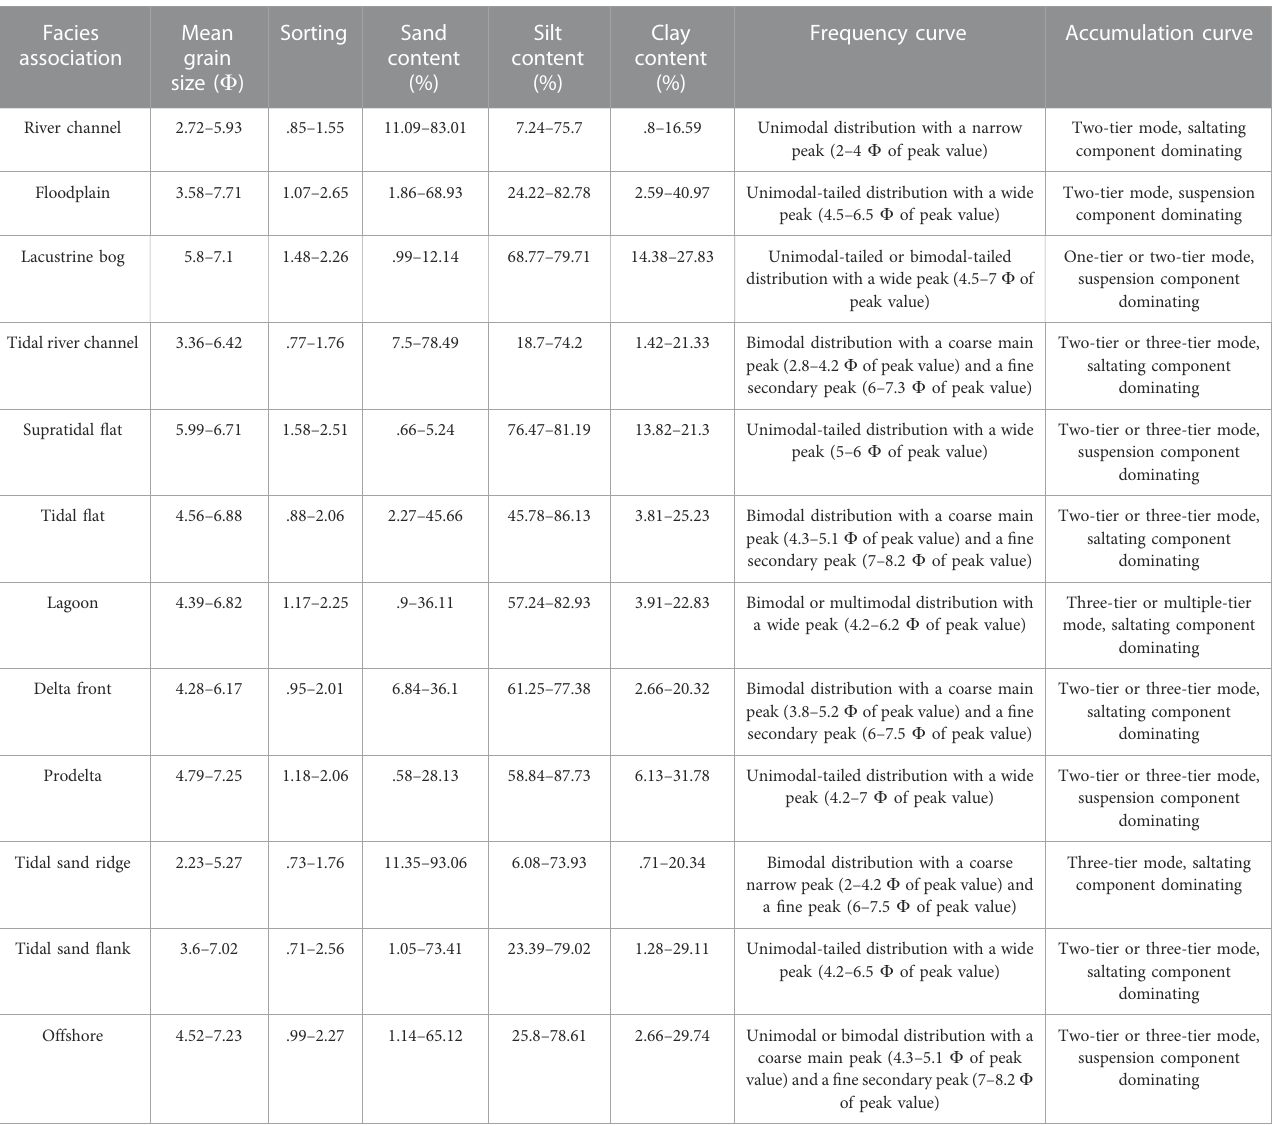
TABLE 4 Summary of grain size characteristics of facies